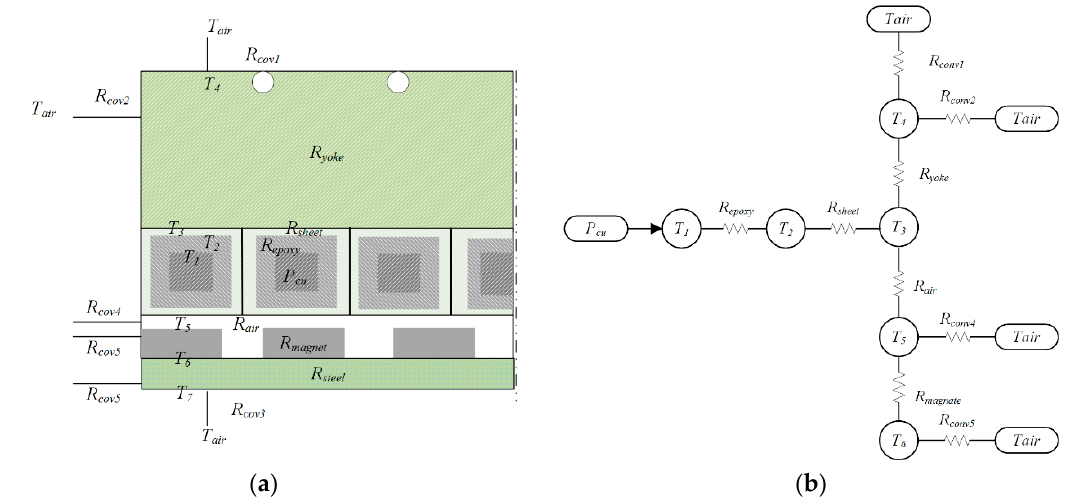
Figure 12. Lumped parameter thermal network (LPTN) model of a PMLSM. ( a ) Simplified motor structure. ( b ) Simplified thermal resistance network. Reprinted with permission from ref. [10]. Copyright 2015